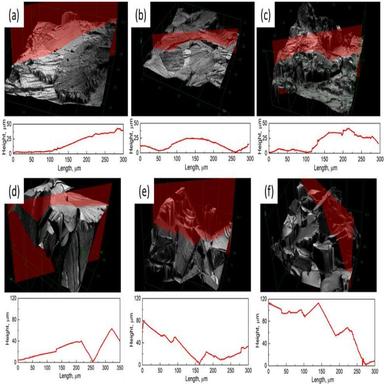
The 3D CLSM images with corresponding topographic profiles for QC – (a–c) and TC – (d–f) regions on the fracture surfaces of the technically pure iron – (a, d), Fe-2.5%Si alloy – (b, e) and low-carbon steel S235JR – (c, f).